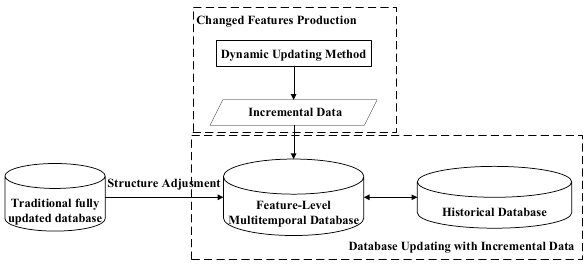
Figure 7 . General technical design of dynamic updating of